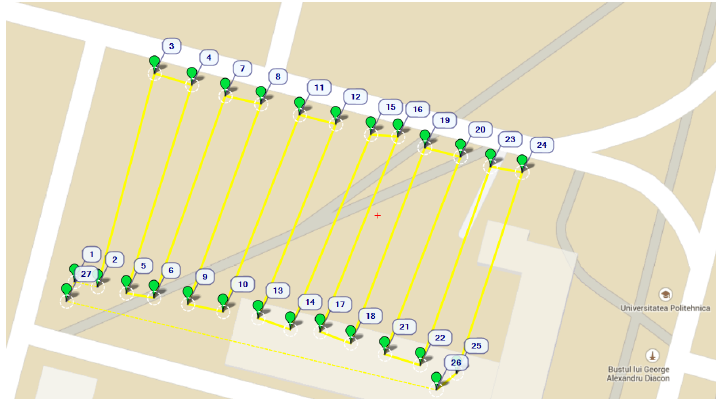
Figure 5. Mission